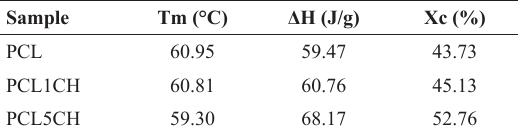
Table 2: Melting temperature, fusion enthalpy and crystallinity degree of PCL and PCL-coffee husk composite films. Sample